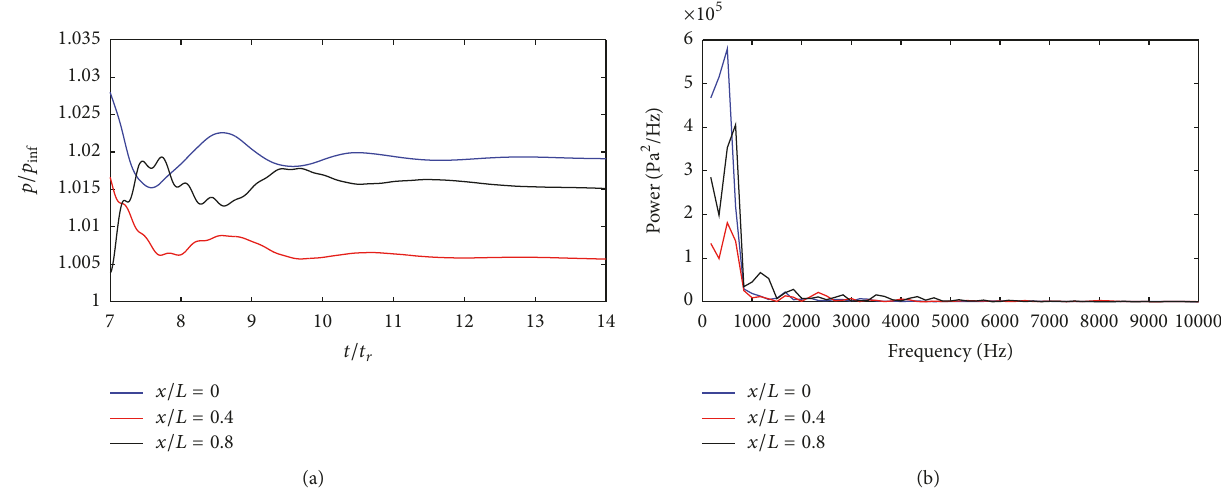
Figure 19: The results for cavity floor ( 𝑥/𝐿 = 0 , 0.4, and 0.8). (a) Pressure distribution. (b) Power spectrum (TWM